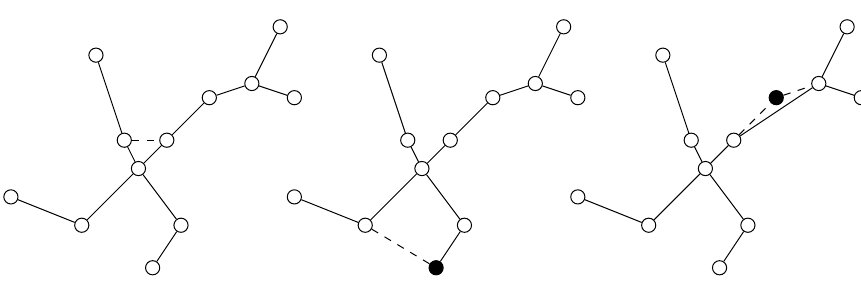
Figure 1 Left ( LB 0 ): a minimum spanning 1-tree, made by a minimum spanning tree and a minimum cost edge (dashed). Center ( LB H ): a Helsgaun 1-tree, made by a minimum spanning tree and a minimum cost edge (dashed) incident to a leaf (filled). Right ( LB HK ): a Held–Karp 1-tree, made by a minimum spanning tree disregarding a vertex (filled) and two minimum cost edges incident to it (dashed). The comparison illustrates the difference between the three corresponding lower